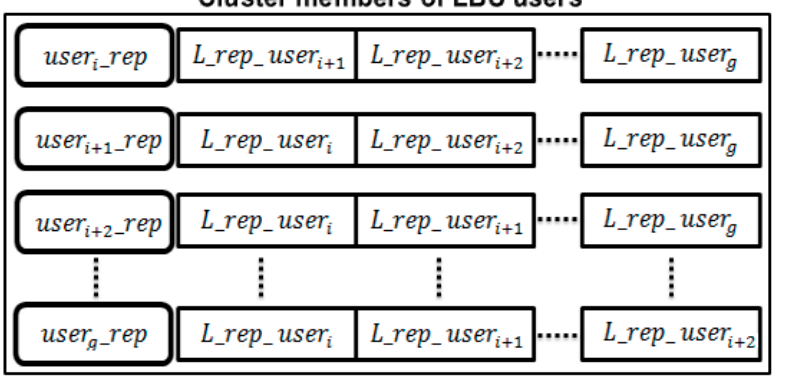
Figure 5. Local reputations of cluster members.